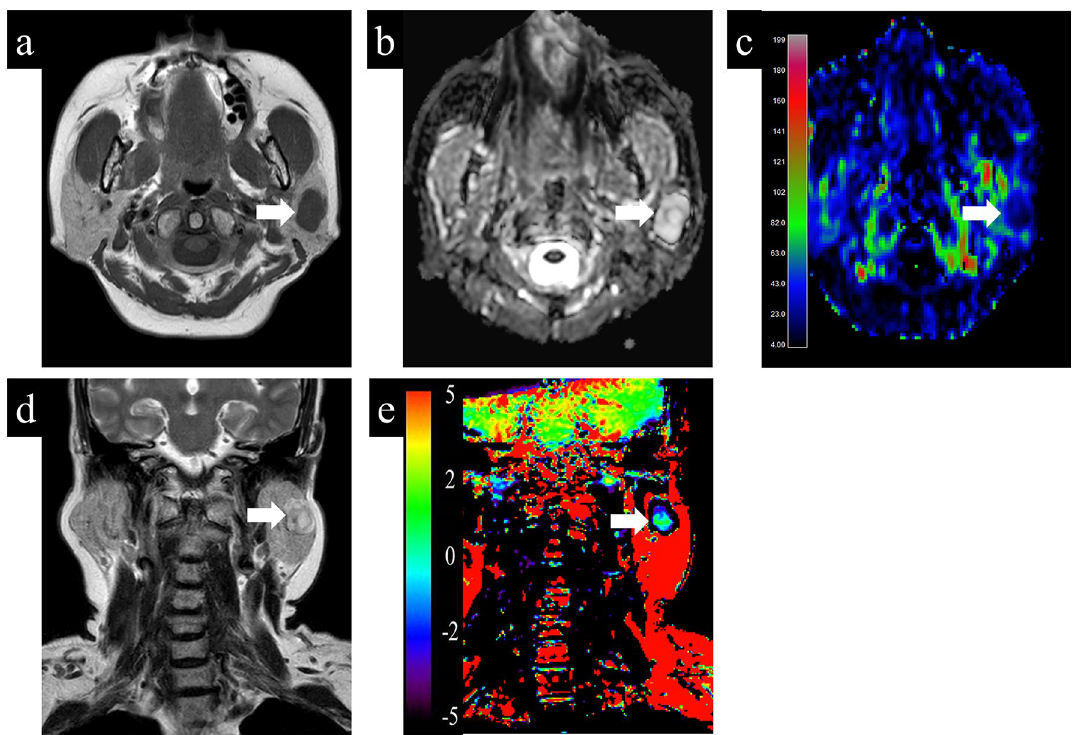
Figure 4. A 68-year-old female with pleomorphic adenoma. ( a ) T1-weighted image shows a homogeneous low intensity lesion in the left parotid gland. Apparent diffusion coefficient (ADC) ( b ) and tumor blood flow (TBF) ( c ) maps show the lesion with the mean ADC value of 1.88 × 10 −3 mm 2 /s and the mean TBF value of 22.55 mL/100 g/min, respectively. On T2-weighted coronal image ( d ), the lesion shows higher signal intensity than the adjacent parotid gland parenchyma. Amide proton transfer (APT) ( e ) map shows the lesion with the mean APT-related signal intensity of 0.26%. An arrow in each image indicates the